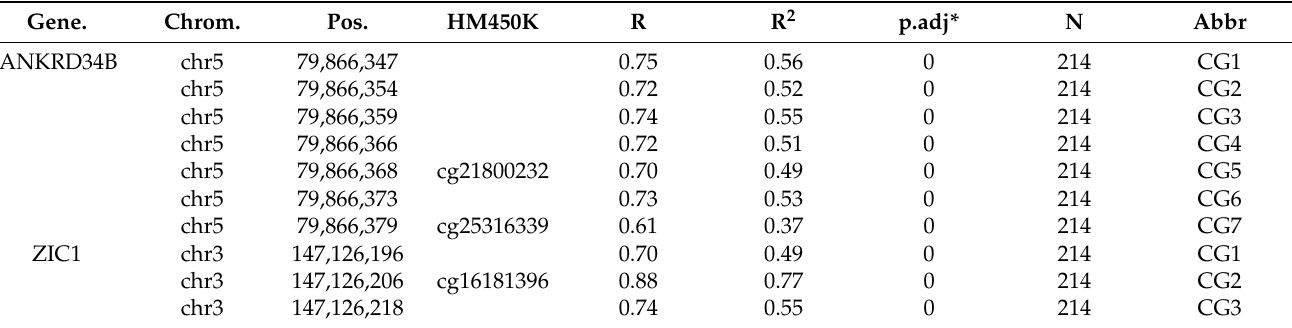
Figure 1. Genomic organization of candidate regions of ANKRD34B ( A ) and ZIC1 ( B ) showing exons (thick orange rectangular boxes), genomic regions corresponding to UTRs (thinner orange boxes, only for ZIC1), CpG islands (CGI), all (CpG sites) and KIRC annotated CpG sites (KIRC), location of candidate sites (Candid.) and pyro sequencing assay (Assay). Table 1. Genomic positions of CpG sites in candidate regions and results of Pearson’s correlation analysis for association of methylation and age in normal autopsy renal